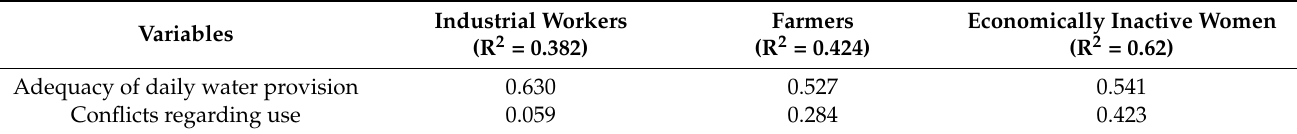
Table 10. Significant predictors of use component.